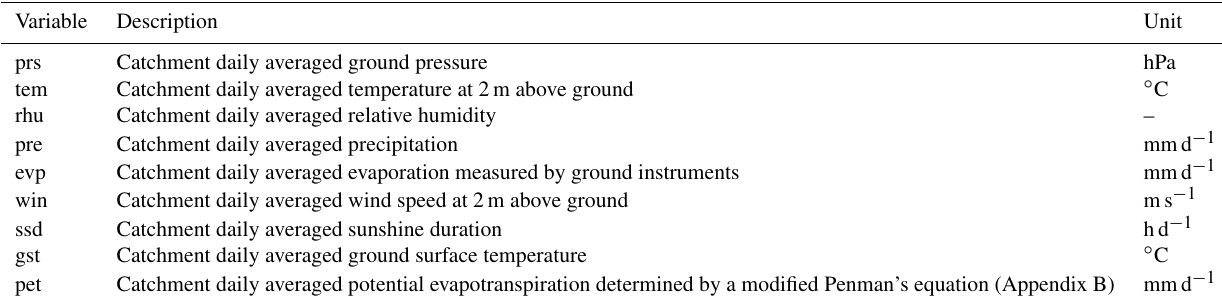
Figure 6. Distributions of topographic characteristics throughout China. Table 3. Summary table of catchment meteorological time series available in the proposed